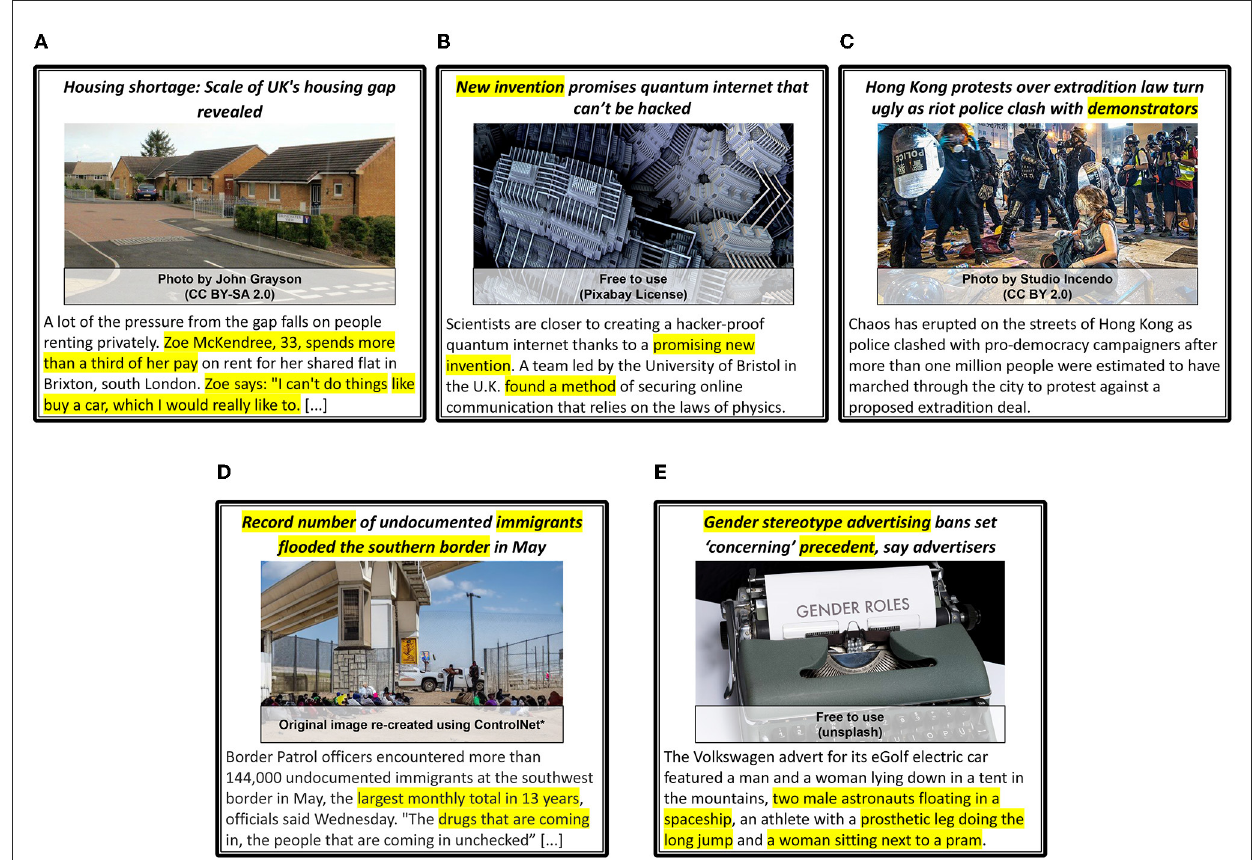
FIGURE12 Personalisation , Novelty and Consonance news values examples. All news values are described as Category , (textual or visual cues), [Modalities: I (Image), T (Text)] . The segments in text that mention important words or phrases that indicate new or reoccurring events, mentions of disasters, etc. are highlighted (yellow). *Used ControlNet (Zhang and Agrawala, 2023) to re-create images because of licensing issues. (A) Personalisation : Yes, (Personal account), [T], Novelty : No, [I,T], Consonance : No, [I,T]. (B) Personalisation : No, [I,T], Novelty : Yes, (new invention) [T], Consonance : No, [I,T]. (C) Personalisation : Yes, (Focus on protestor), [I], Novelty : Yes, (contrast b/w police vs protestor) [I], Consonance : No, [I,T]. (D) Personalisation : No, [I,T], Novelty : Yes, (record number, police vs immigrants) [I,T], Consonance : Yes, (flooded, drugs, image usage) [I,T]. (E) Personalisation : No,